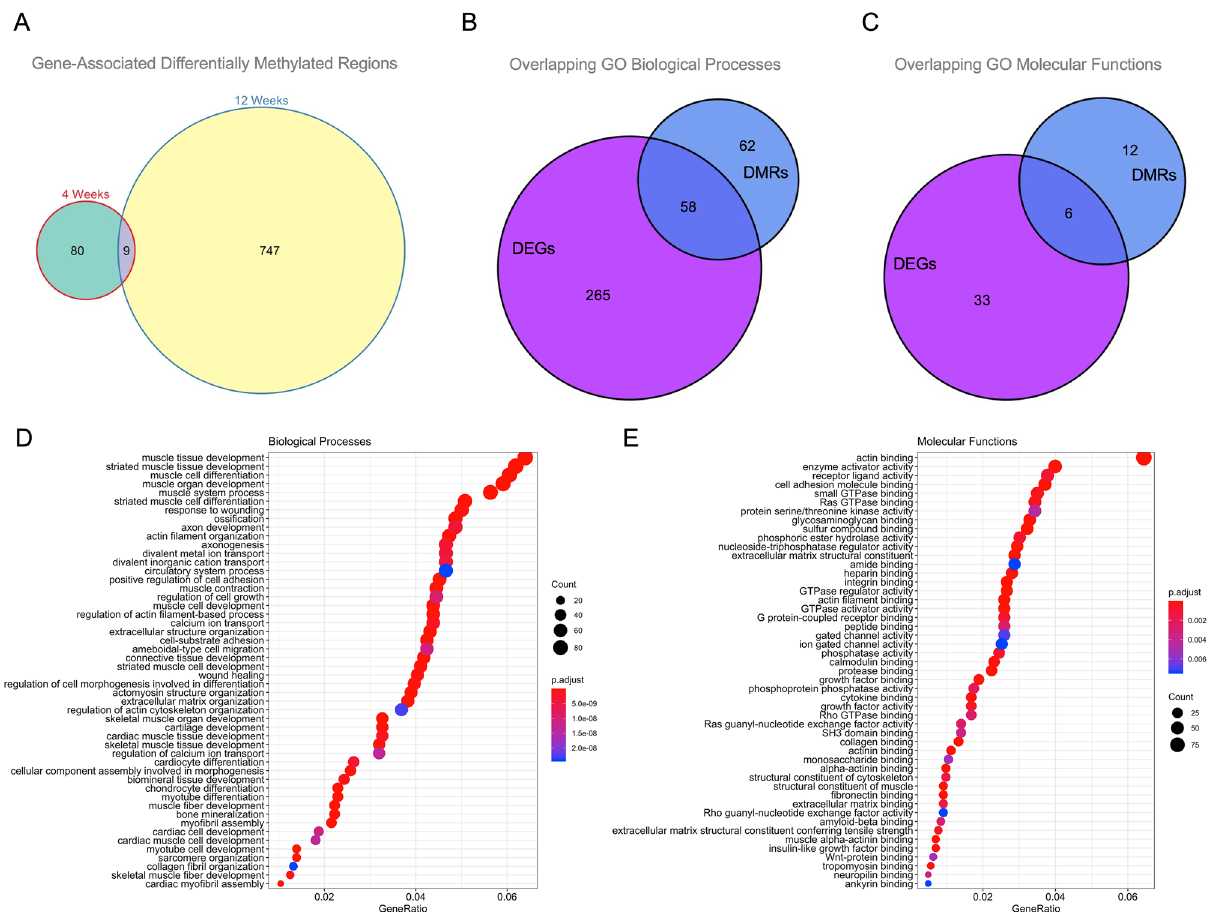
Figure 2. RRoxBS analyses identified changes in 5mC and 5hmC in mouse cartilage isolated after surgical induction of OA. ( A ) Changes in gene-associated, differentially methylated regions (DMRs, 25% difference in methylation and q value < 0.05) in microdissected cartilage at 4 and 12 weeks after induction of OA. Overlapping significantly enriched ( B ) Biological Processes and ( C ) Molecular Functions comparing gene expression (RNA- seq) and DNA methylation (RRoxBS, 5mC). Representation of the ( D ) Biological Processes (top 50) and ( E ) Molecular Functions significantly enriched (FDR < 0.05) for all significant genes, using differentially methylated regions (DMRs) and differentially expressed genes (DEGs) in OA vs. non-OA mouse cartilage The progression of osteoarthritis after DMM surgery is accompanied by changes in methyla - tion patterns in articular cartilage. OA chondrocytes undergo phenotypic and functional alterations that are in part driven by changes in DNA methylation 2 , including changes in 5hmC following DMM 8 . To evalu- ate how the structural and transcriptomic changes following DMM are associated with changes in 5mC and 5hmC, we conducted Reduced Representation Oxidative Bisulfite Sequencing (RRoxBS) analyses 21,22 . These analyses uncovered significant differences in hyper- and hypo-methylation at 4 and 12 weeks after DMM (Sup- plementary Figure S3). Using at least a 25% methylation difference and q-value of less than 0.05 in compari- sons between DMM and control samples, we identified 842 differentially methylated 5mCs and 318 5hmCs at 4 weeks after DMM, and a pronounced increase in the number of differentially methylated cytosines (DMCs) at 12 weeks. This was particularly evident for 5mCs, with 3614 differentially methylated 5mCs at 12 weeks and 480 differentially methylated 5hmCs (Supplementary Table S3). The impact of 5hmC in OA has been reported using the DMM model and Tet1 deficient mice 8 . Thus, we focused on true methyl data (5mC) for our downstream analyses. First, we used 5mC data to identify differentially methylated regions (DMRs). We defined DMR as a genomic region with at least 3 CpGs within 100 bp, where at least 1 CpG is significantly differentially methylated (25% 5mC methylation difference and q value < 0.01). The overall differential methylation of 5mC averaged at least 20% across all the CpGs in this DMR. We identified 89 DMRs associated with 90 unique gene symbols at 4 weeks, and 756 DMRs associated with 489 unique gene symbols at 12 weeks, with 9 common DMRs (Fig. 2A and Supplementary Table S4). Functional integration of DEGs and DMRs at 4 and 12 weeks via GO categories revealed 58 overlapping biological processes (Fig. 2B), and 6 overlapping molecular functions (Fig. 2C) significantly enriched in OA cartilage, including collagen binding (with Aspn , Itgb1 , Lrrc15 , or Smad3 ), extracellular matrix structural constituent (including Aspn , Col4a1 , Col5a1 , or Col6a3 ), or integrin binding (with Itgb1 , Itgb3 , Itgb4 or Timp2 ). See Table 1 for a list of selected GO categories,